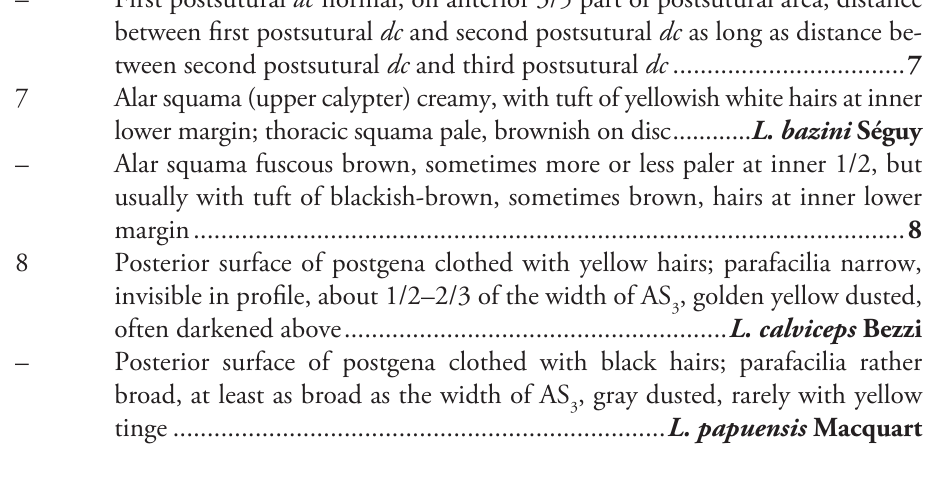
Subfamily BENGALIINAE Key to the species of Bengalia 1 Prealar knob pointed; fourth sternite (ST ) with 1 pair of long and strong 4 median marginal bristles ( mb ) in male; abdomen very slightly pollinose; body small- to medium-sized; mesonotum blackish on disc .... B. calilungae Rueda